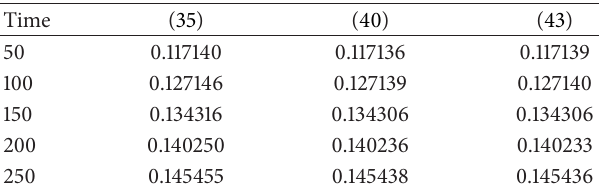
Table 6: Table showing max 𝑢(𝑥,𝑡) for each of the schemes, where 𝛼 = 5 .